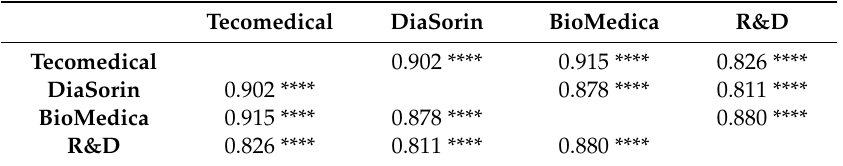
Table 4. Serum sclerostin levels of the total end-stage kidney disease (ESKD) cohort and according to the percentage of sclerostin-positive lacunae (i.e., below versus equal or above the median of 43%). ESKD Patients All